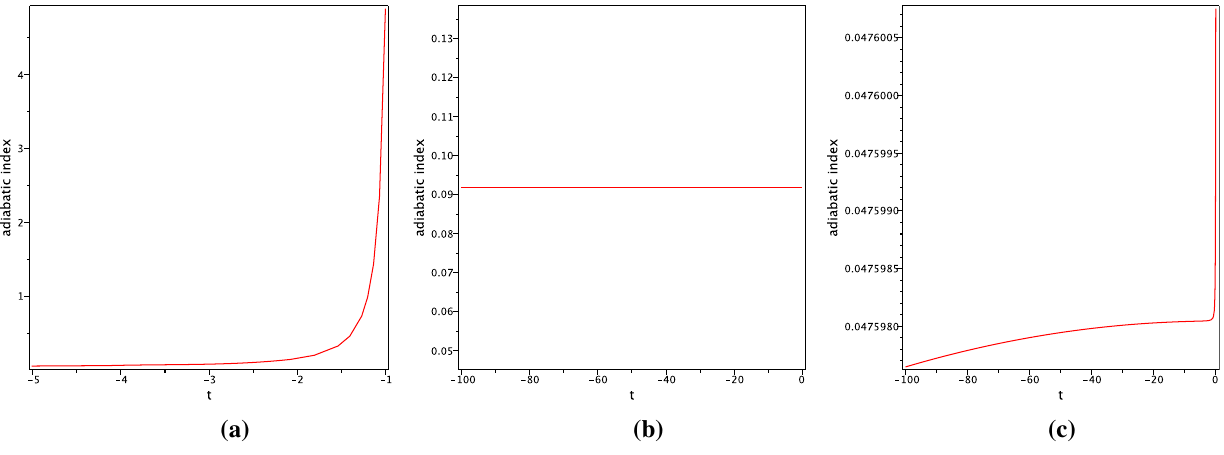
Fig. 11 a – c Shows the plots of adiabatic index at r = r (cid:5) = 1, w.r.t. time t for f ( R ) = R + λ R 2 with λ = 5, f ( R ) = R 1 + (cid:3) with (cid:3) = 0 . 01